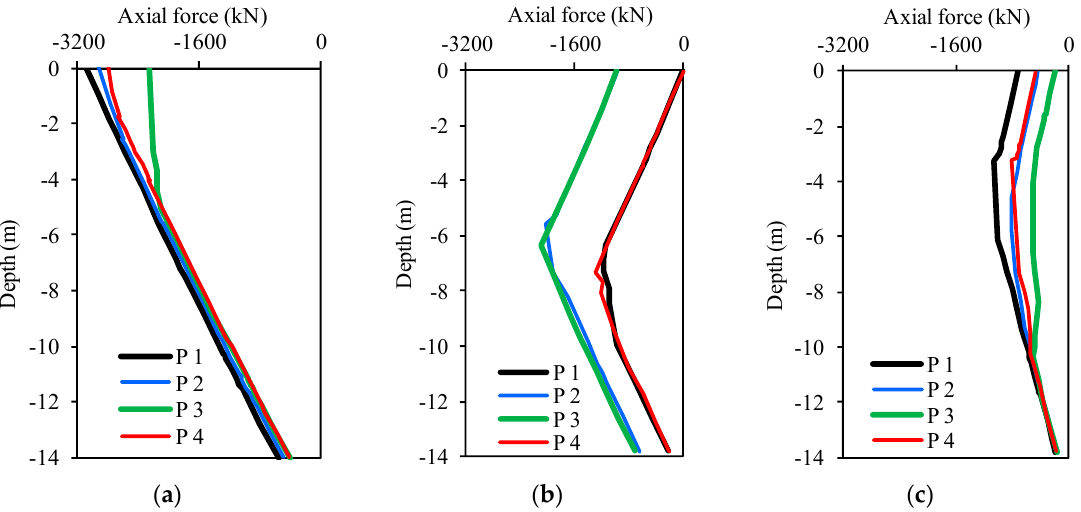
Figure 13. Distribution of the axial force of the pile: ( a ) raft + bored pile; ( b ) raft + cushion + bored pile; ( c ) raft + cushion + CFG pile.